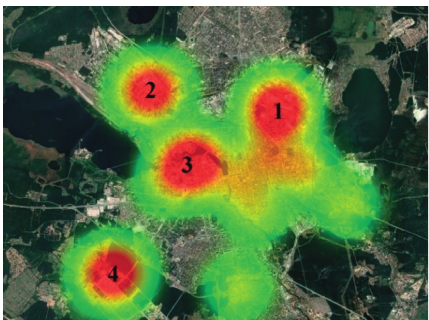
Figure 1: Heat map of price zones of the city of Yekaterinburg. The zones where the most expensive apartments are located are shown in red gradually changing to colder colors as the apartment price